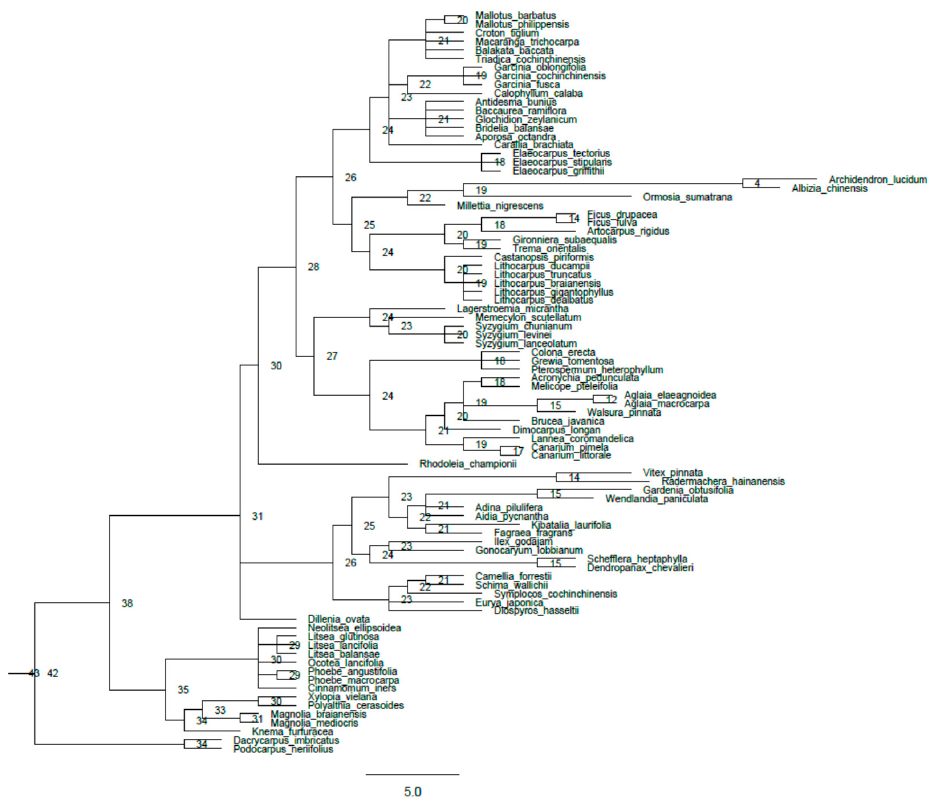
Figure A1. Phylogenetic tree of OGF.